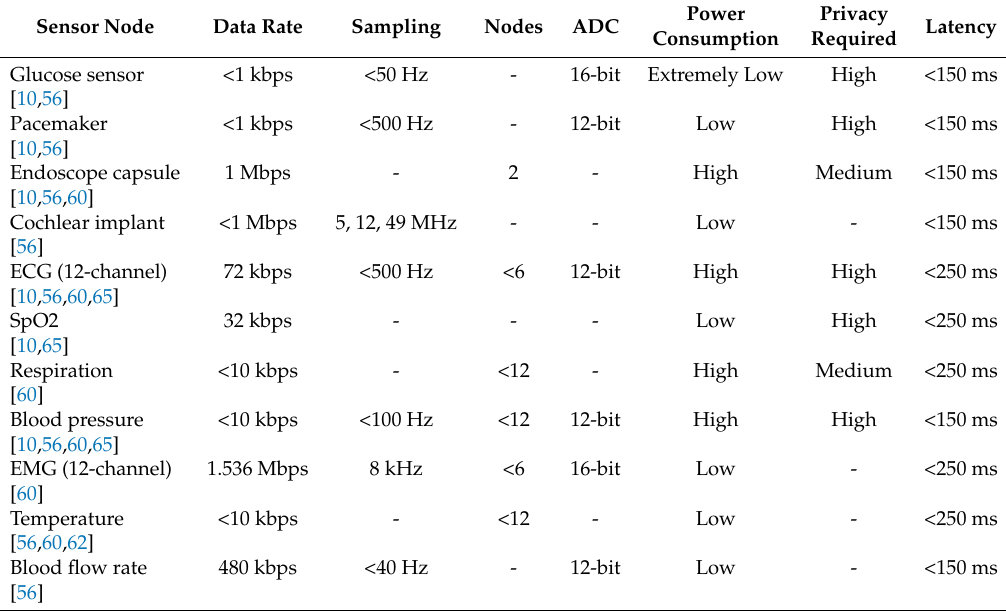
Table 2. Communication parameters for medical